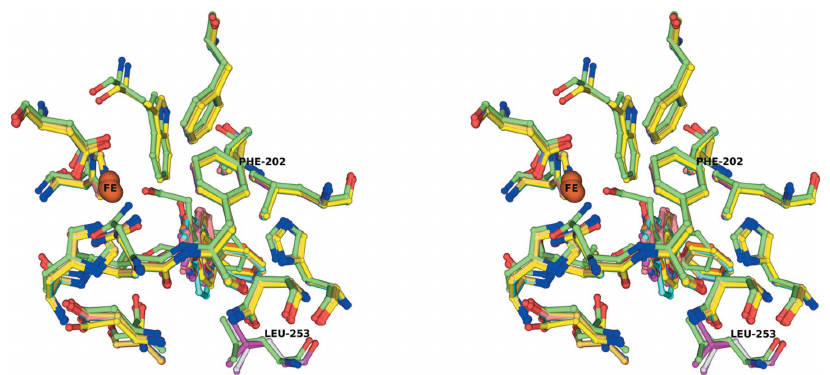
Figure 7 Stereo diagram of a superposition (from all structures discussed in this manuscript) of the residues in the active site, illustrating the changes in conformation of the residues that bind the mononuclear iron and the substrate. The Fe atom, Phe202 and Leu253 are